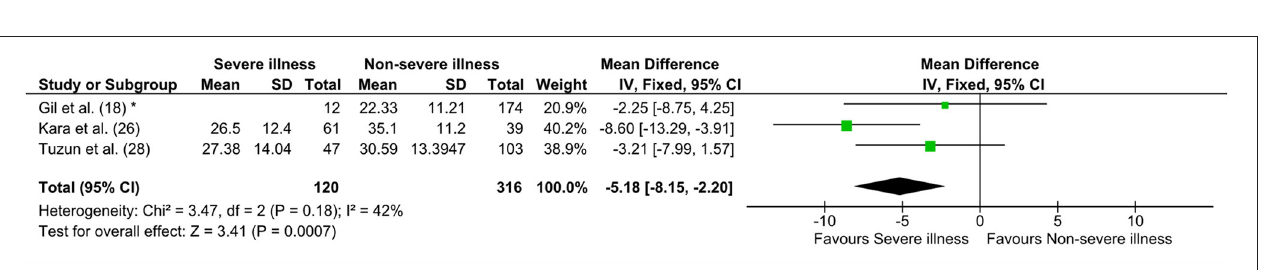
FIGURE 5 | The forest plot of hand grip status and survival rate. *Unpublished data. SD, standard deviation; CI, confidence